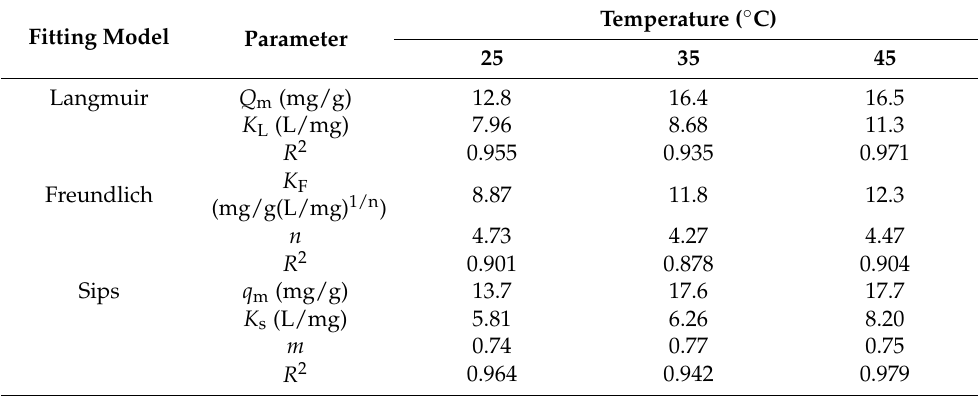
Table 2. Fitting parameters of adsorption isotherm for experimental data.